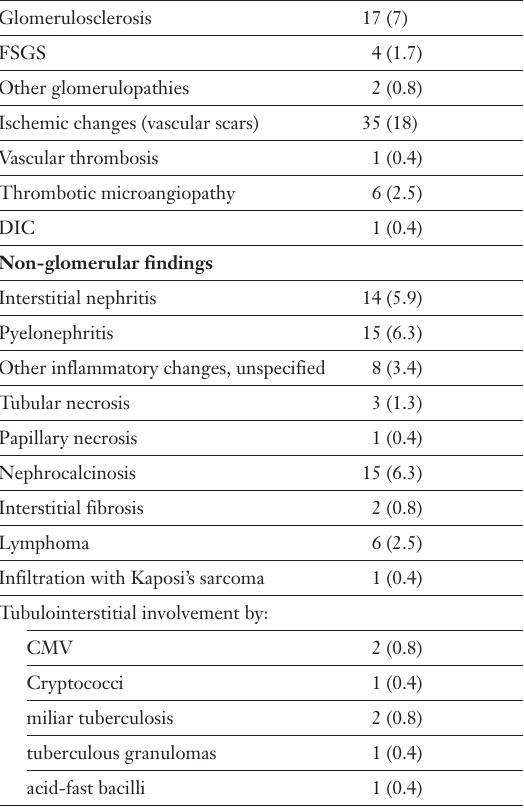
Glomerular and vascular